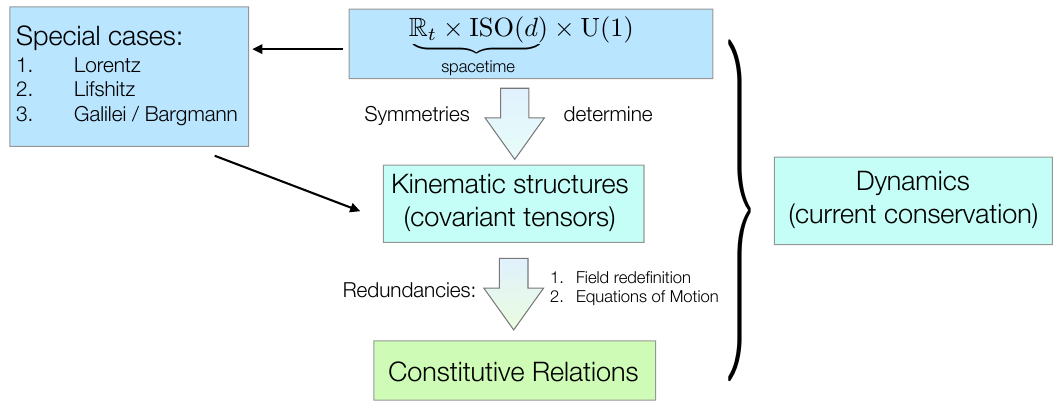
Figure 1 . Here we give the roadmap of our construction. In the spirit of e(cid:11)ective (cid:12)eld theory, we (cid:12)rst identify the most general symmetry group applicable for our purposes. For the purpose of this paper we focus on R t ISO( d ) U(1). Next we write down all possible kinematic structures (cid:2) (cid:2) compatible with that symmetry, which are then constrained by the (cid:12)xing rede(cid:12)nition ambiguities present in the construction. Finally the remaining physical quantities are then subject to a dynam- ical principle, which in the case of hydrodynamics follows simply from conservation of the stress tensor and current. From the most general and therefore least constrained structure we also recover more highly symmetric previously known examples as limiting cases as shown in the leftmost